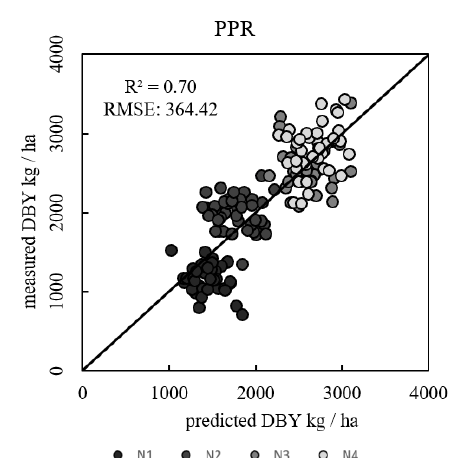
Figure 9. Measured versus predicted dry biomass yield [kg / ha] for PPR.